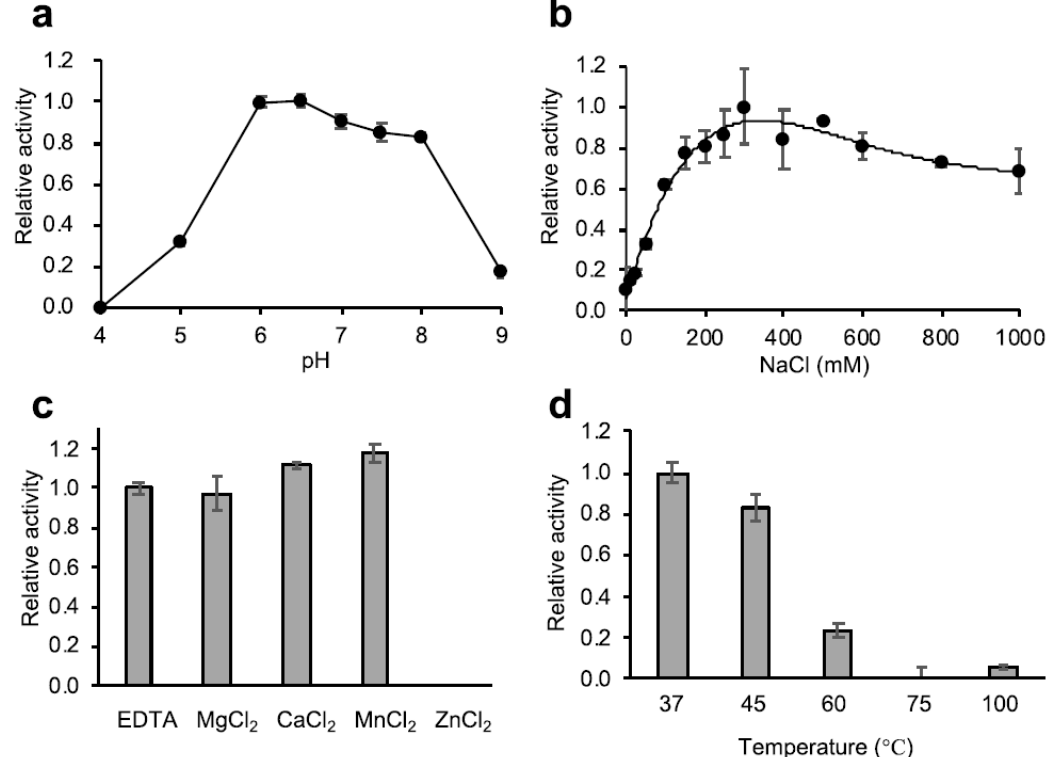
Figure 3. Characterization of the lytic activity of Psa-his. The lytic activity of Psa (1 U) against C. perfringens HN1314 was determined using the turbidity reduction assay. ( a ) Optimal pH of Psa-his. The relative activity at pH 6.0 was set as 1. ( b ) The effect of NaCl on Psa-his lytic activity was determined, and the relative activity at 300 mM NaCl was set as 1. ( c ) The effects of divalent metal cations on Psa-his lytic activity were determined by the addition of 1 mM MgCl 2 , CaCl 2 , MnCl 2 , ZnCl 2 , or EDTA. The relative activities are shown with activity in the absence of divalent cations (with 1 mM EDTA) set as 1. ( d ) The thermal-stability of Psa-his lytic activity was determined by measuring lytic activity after 10 min of heat treatment at 37, 45, 60, 75, and 100 ◦ C. The relative activity at 37 ◦ C was set as